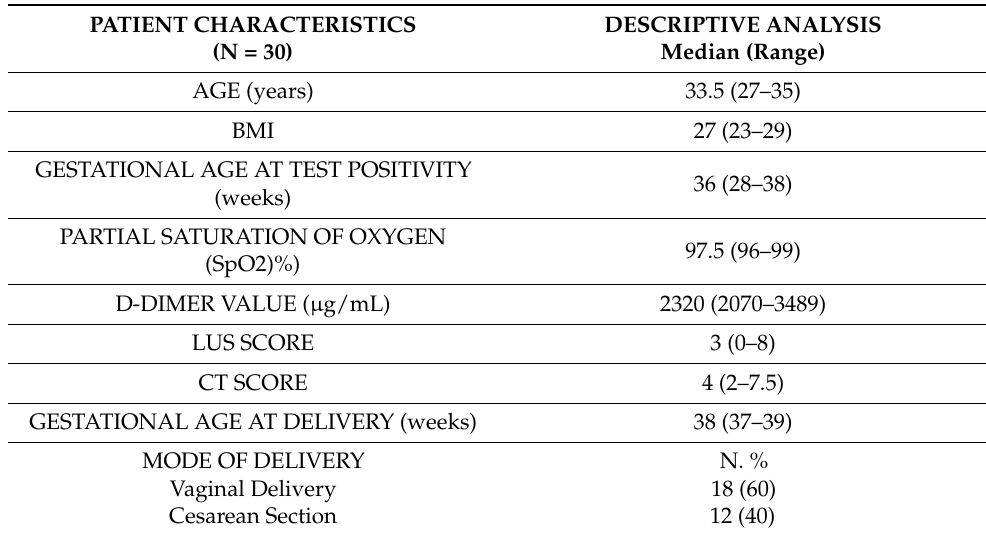
Table 1. Descriptive analysis of main patients’ characteristics using median and (interquartile range) or number